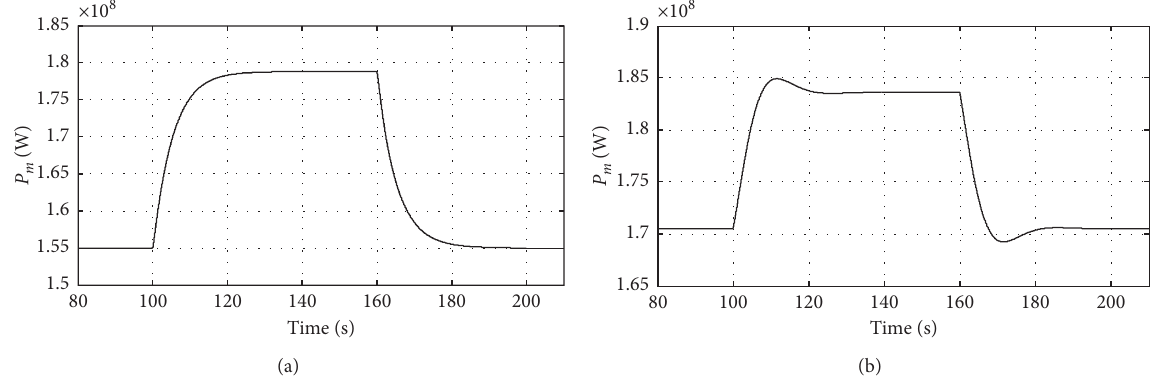
Figure 39: Comparison diagram of the pump turbine mechanical power. (a) Power priority control strategy. (b) Speed priority control